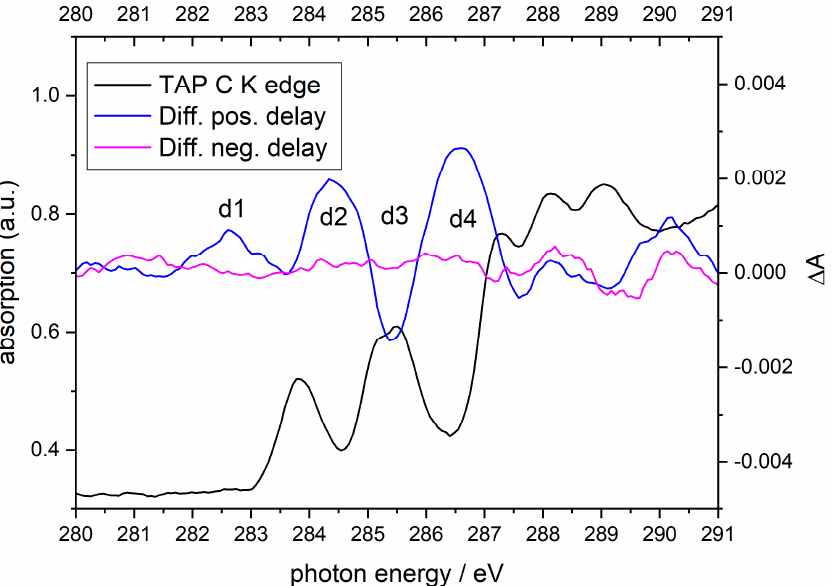
Figure 3. tr-NEXAFS at the carbon K-edge of TAP. The ground state spectrum cf. Figure 2 is shown in black. Die difference spectra with negative and positive time delays between excitation and probing are shown in purple and blue.